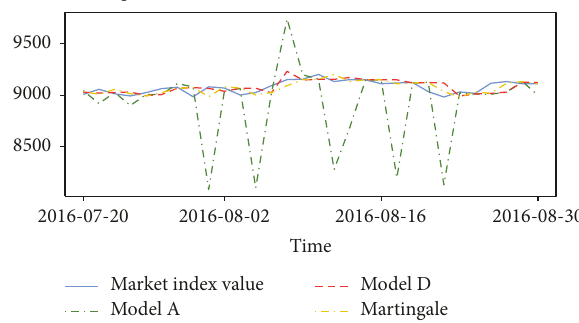
Figure 16: Time plots of raw data and the forecasts of model C.